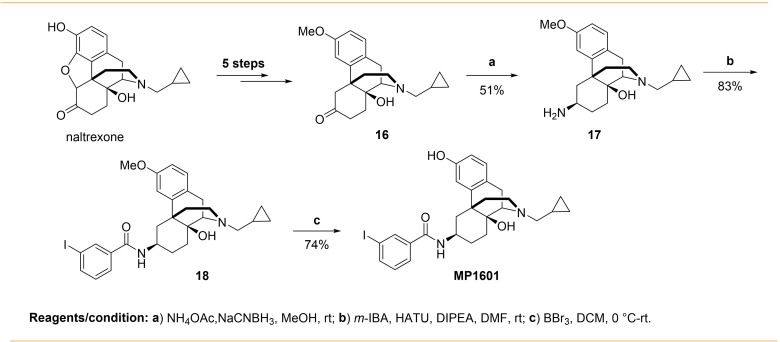
Synthesis of m-iodoarylamido-4,5-deoxymorphinan MP1601.